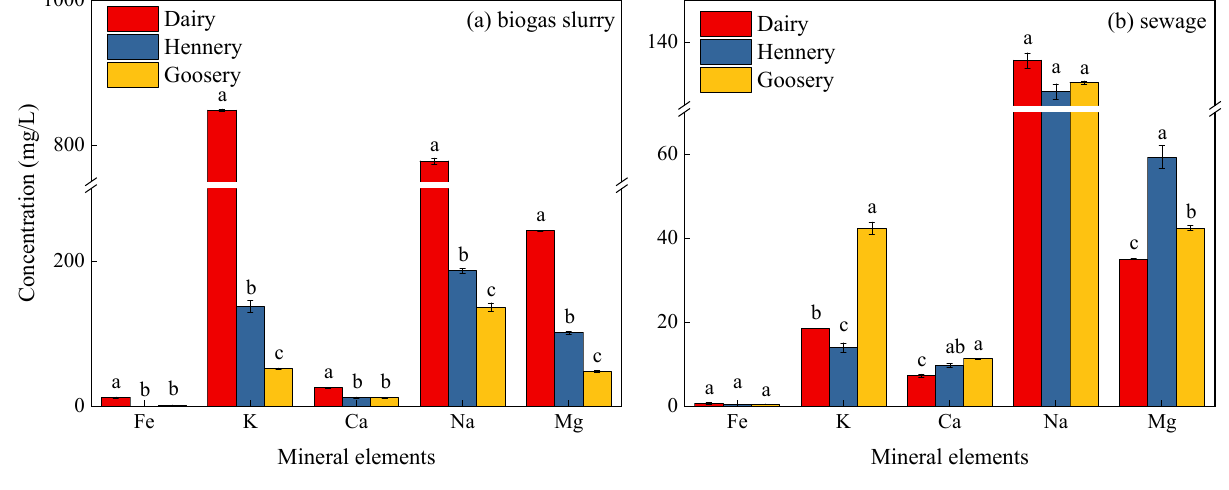
Figure 6. Concentrations of mineral elements in biogas slurry ( a ) and sewage ( b ) from three types of farms. Different letters indicate significant differences between different types of farms ( p < 0.05).